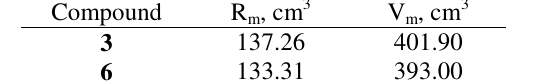
and V of compounds 3 and m m